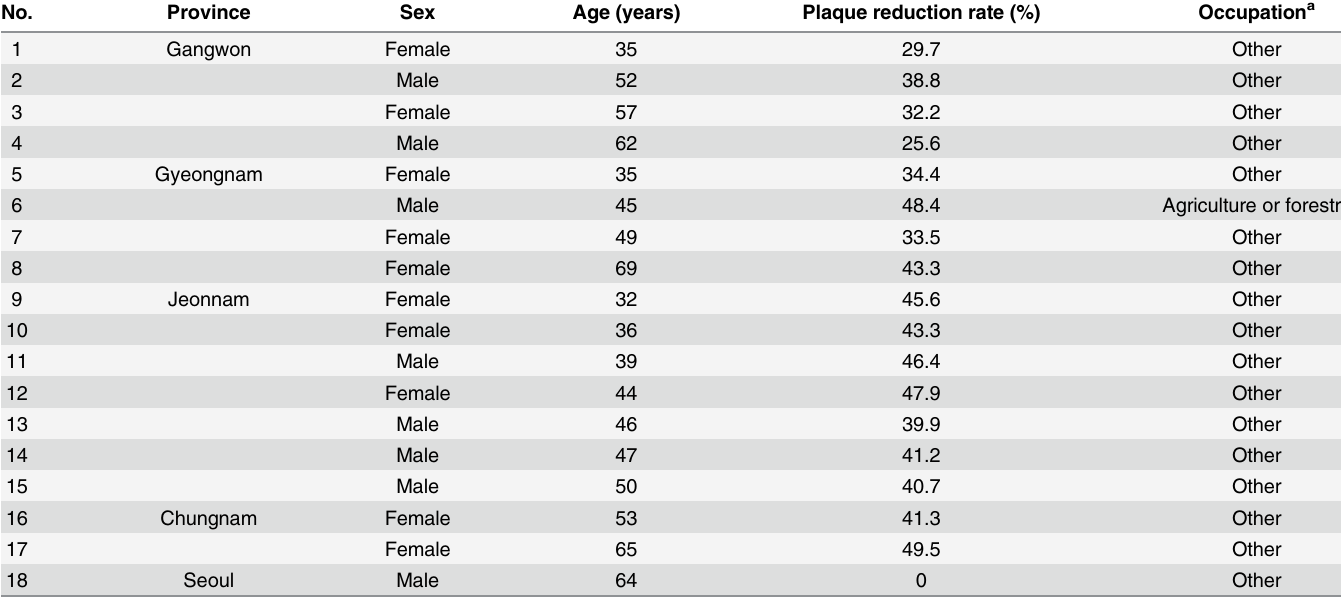
Table 5. Demographics of subjects with no neutralizing antibody to Japanese encephalitis virus. No.